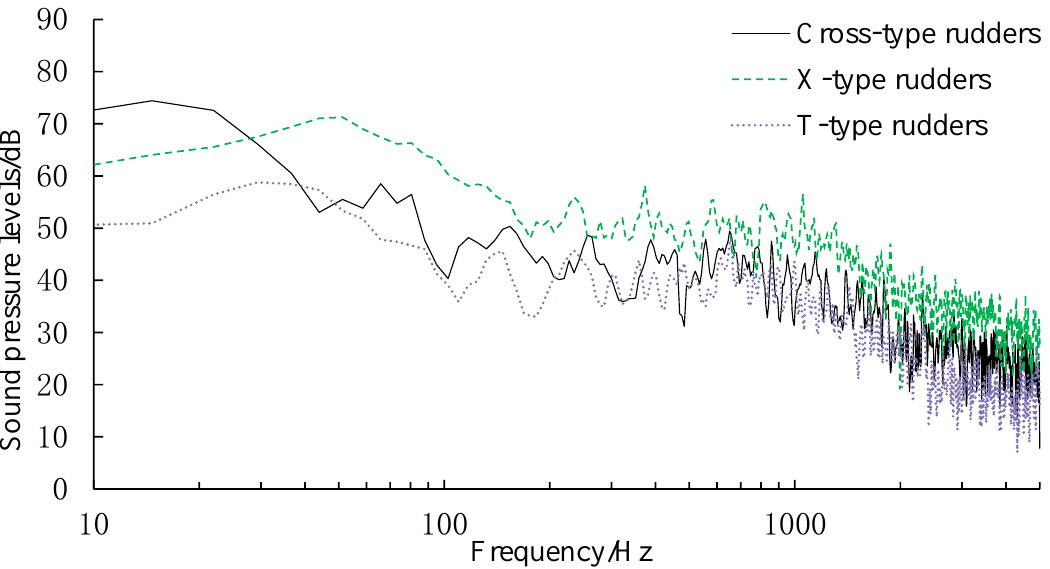
Figure 22. Directivity of sound pressure levels of different underwater vehicle stern rudder parts.